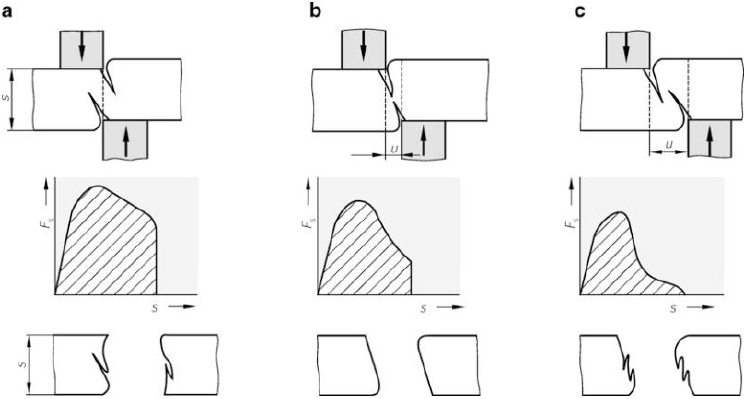
Figure 7. Influence of the dimensioning of the clearance on the cut surface quality with ( a ) too small clearance, ( b ) correct dimensioned clearance and ( c ) too big clearance [15].